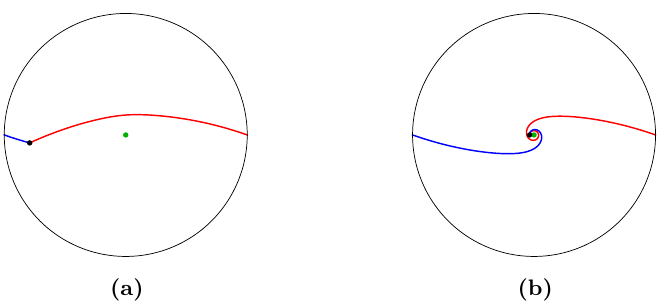
Figure 16. Two examples of intersecting annulus brane configurations. In (a) α = 0 . 95 , so the intersection is close to the conformal boundary and the configuration is almost like a single smooth brane. In (b) α = 0 . 2 , so the intersection point is close to the center. The configuration (a) is dual to a BCC operator with dimension ∆ bcc ≈ 0 , and the configuration (b) is dual to ∆ bcc ≈ c